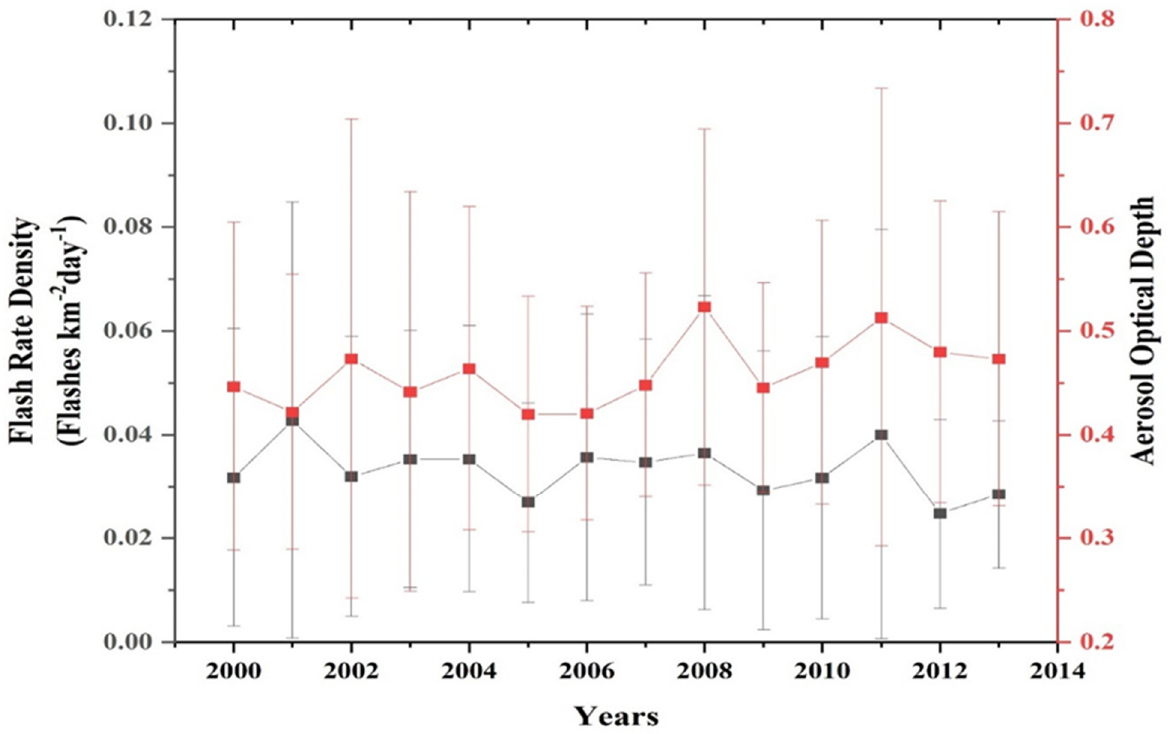
Figure 9. Annual variation for averaged values of lightning flash rate density (LFRD) (on the primary Y -axis) with AOD (on the secondary Y -axis) for the period of 2000–2013 over the study re- gion.